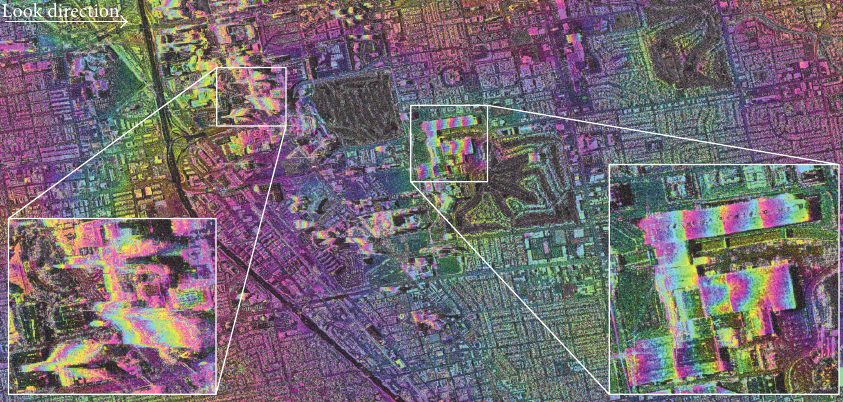
Figure 14: TerraSAR-X flattened interferogram in radar coordinates with amplitude image in background. Subsets show hotels and the Las Vegas Convention Center. Temporal baseline 110 days, perpendicular baseline: